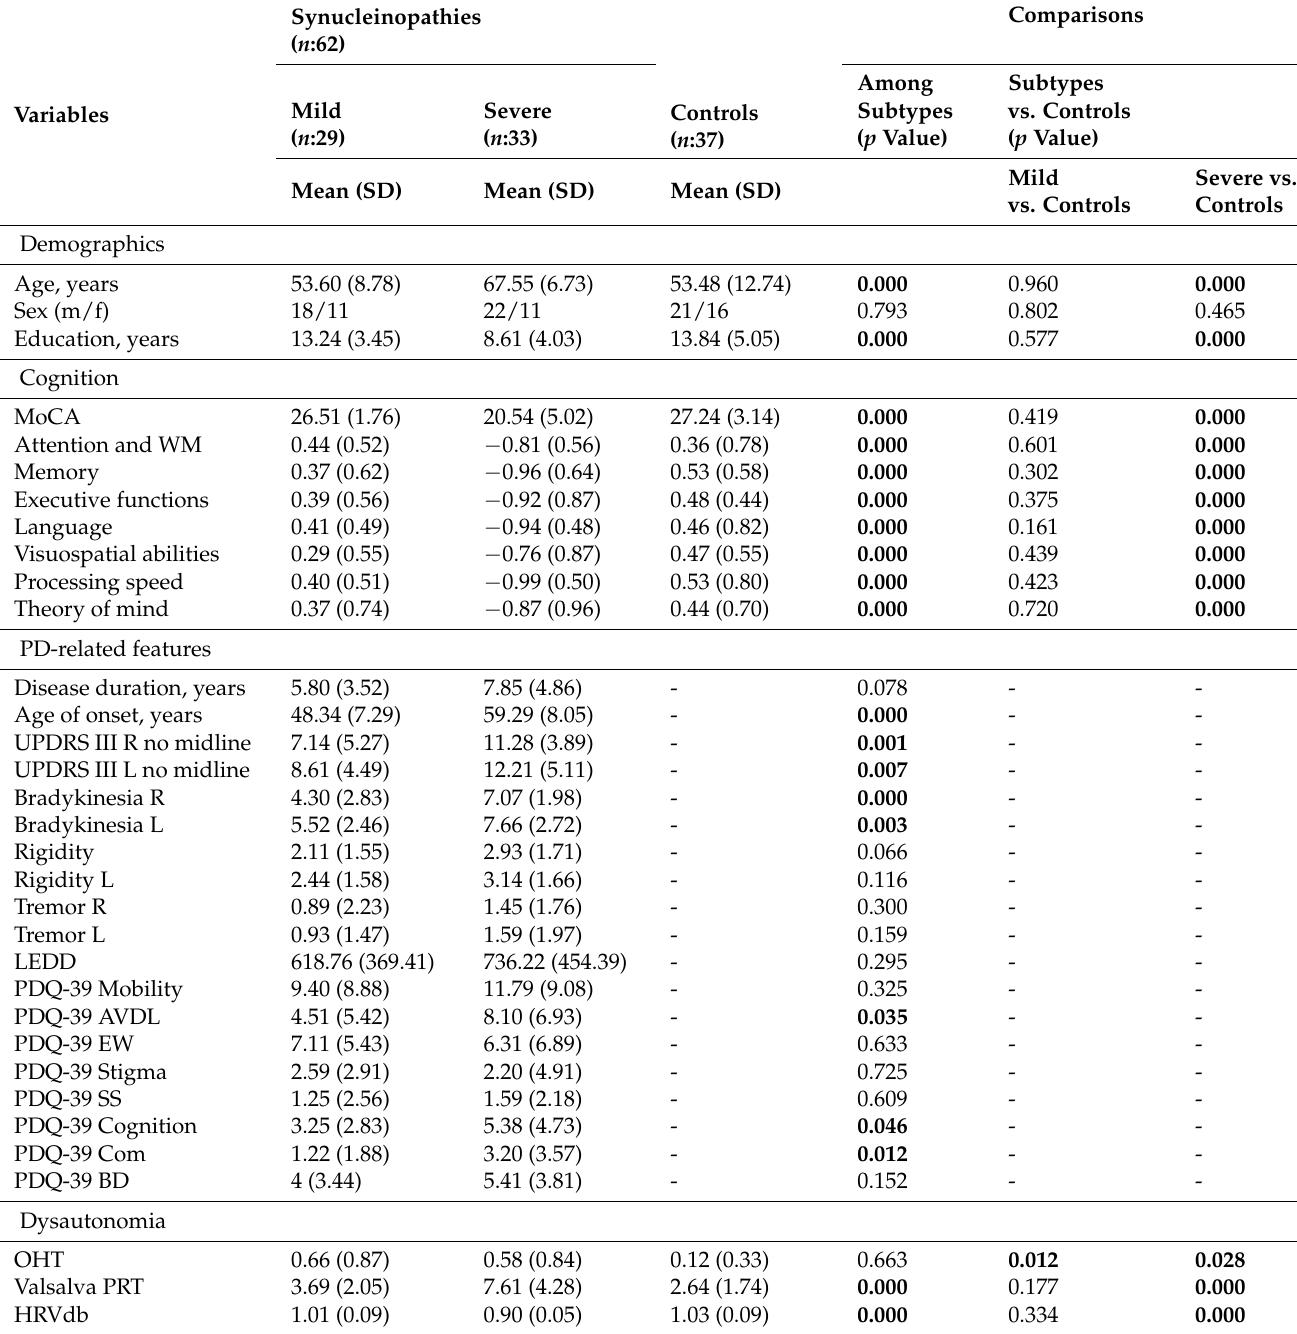
Table 1. Demographic, PD-related, and nonmotor characteristics of the